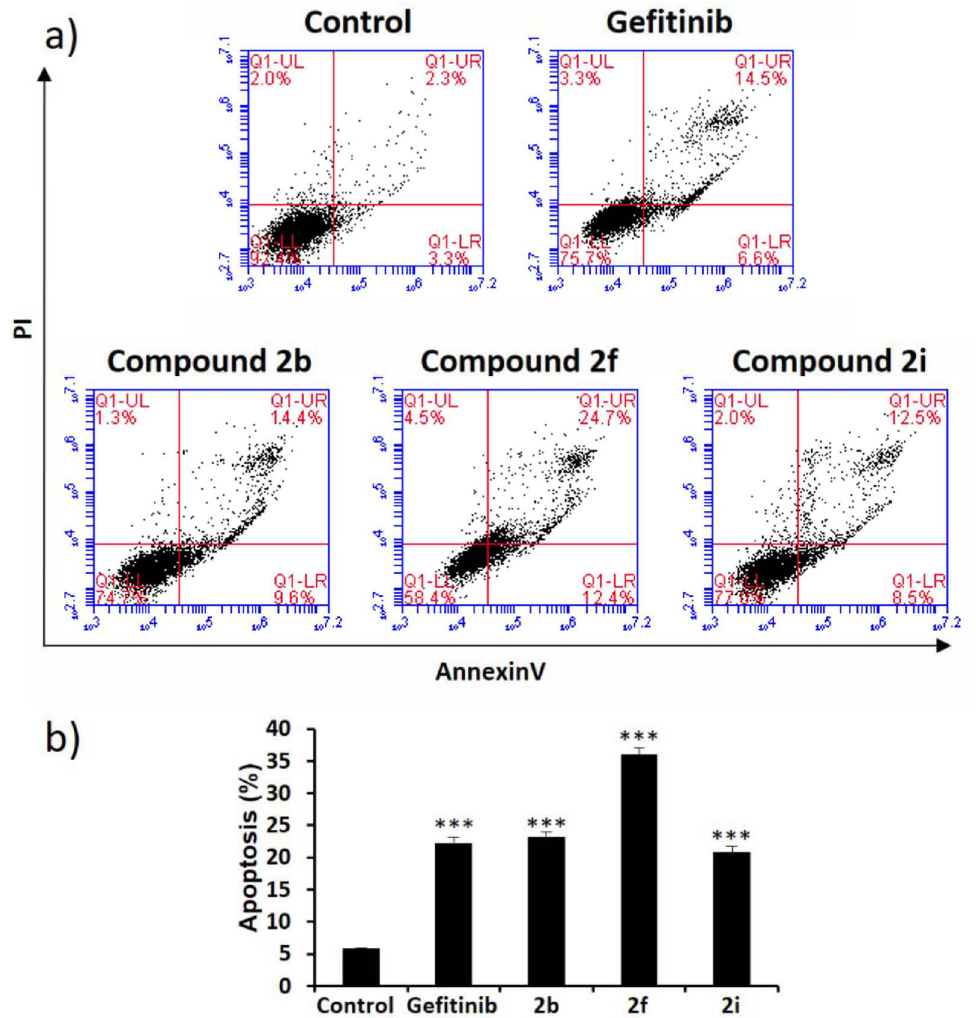
Figure 2. Flow cytometric analysis to determine apoptosis in MDA-MB-468 cells. ( a ) The cells were treated with 10 µ M of gefitinib, and compound 2b , 2f , and 2i , respectively, for 24 h. ( b ) Fluorescence- activated cell sorting (FACS) analysis of propidium iodide (PI) uptake and annexin V binding in non-permeabilized cells (lower-left, live cells; lower-right, early apoptotic cells; upper-right, late apoptotic cells; upper-left, necrotic cells). The quantification of apoptotic cells from three independent experiments. (*** p < 0.001, compared with control